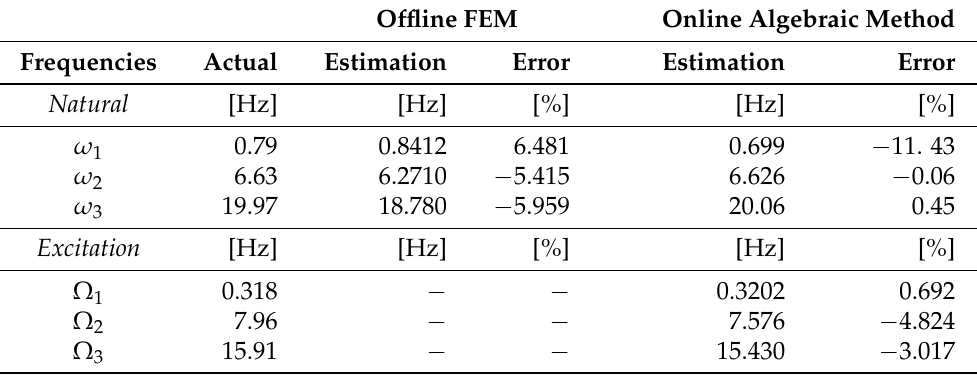
Table 4. Online algebraic estimation of natural and excitation